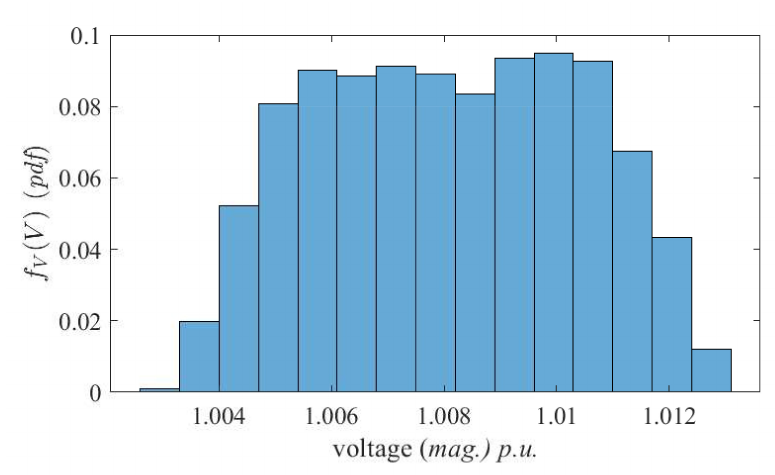
Figure 10. Voltage profile of the Test90 radial network. Solid line: solution without DGs, gray curves: 1000 Monte Carlo simulations where the DGs are varied in a 20% range around their nominal supply rating.